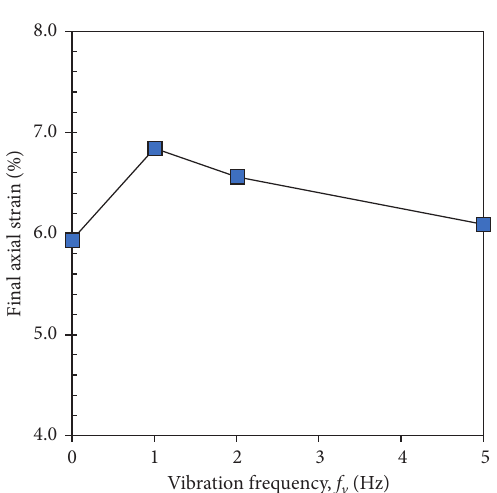
Figure 6: Variation of final axial strain with vibration frequency.